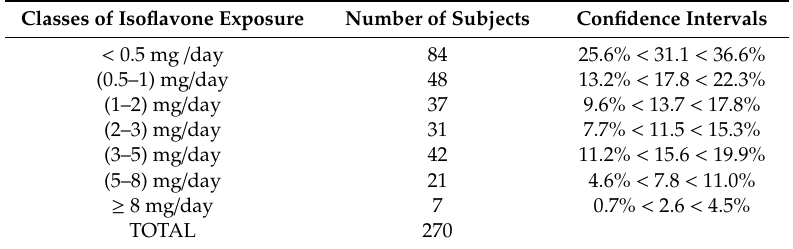
Table 4. Distribution of isoflavone exposure in French premenopausal women through a casual diet containing soy as an